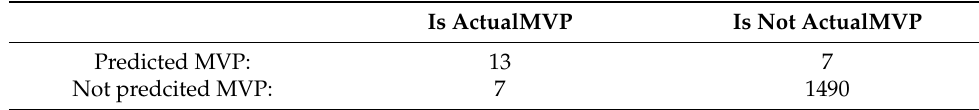
Table 1. Confusion matrix for MVP predictor